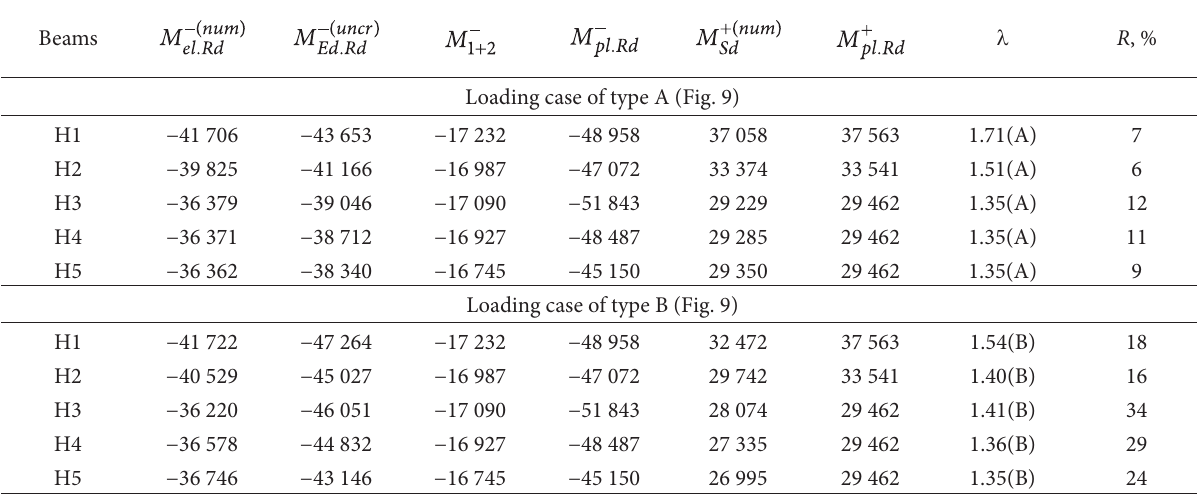
Table 6. Hogging and sagging bending, kNm – see Table 3 (class 3) – all options – local buckling included Beams Loading case of type A (Fig.